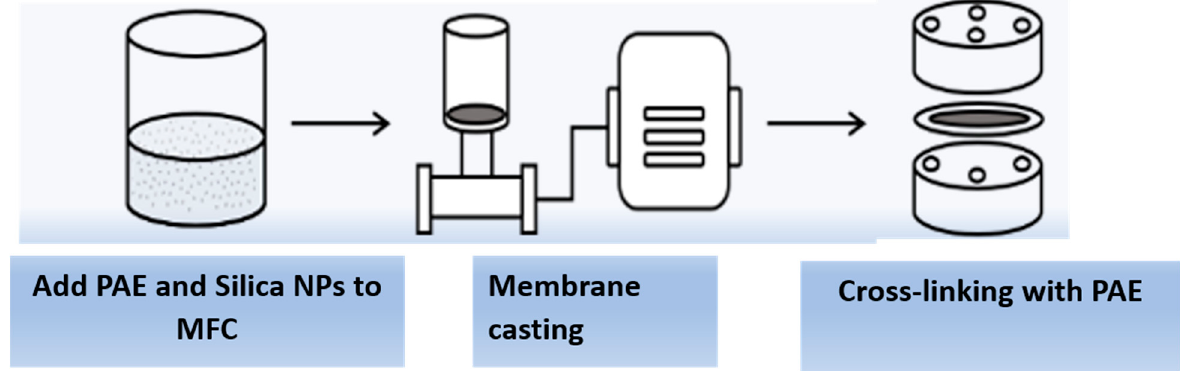
Figure 2. Schematic of the membrane fabrication process for the cellulose membrane.